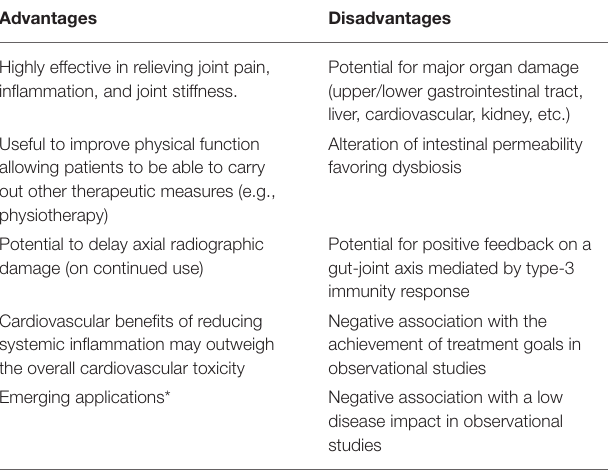
TABLE 1 | Potential advantages and disadvantages of NSAIDs for treating axial SpA.